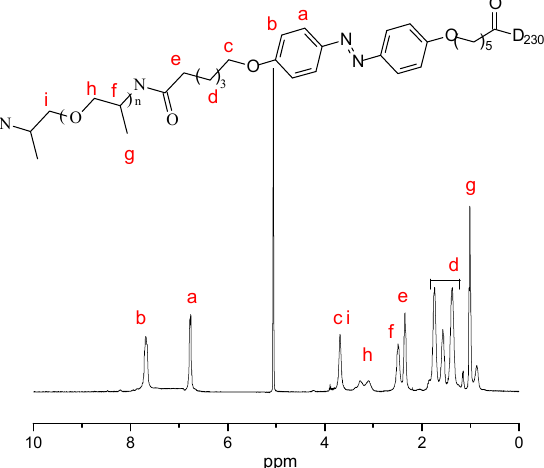
Figure 2. 1 H NMR spectrum of compound 2 in chloroform-d.